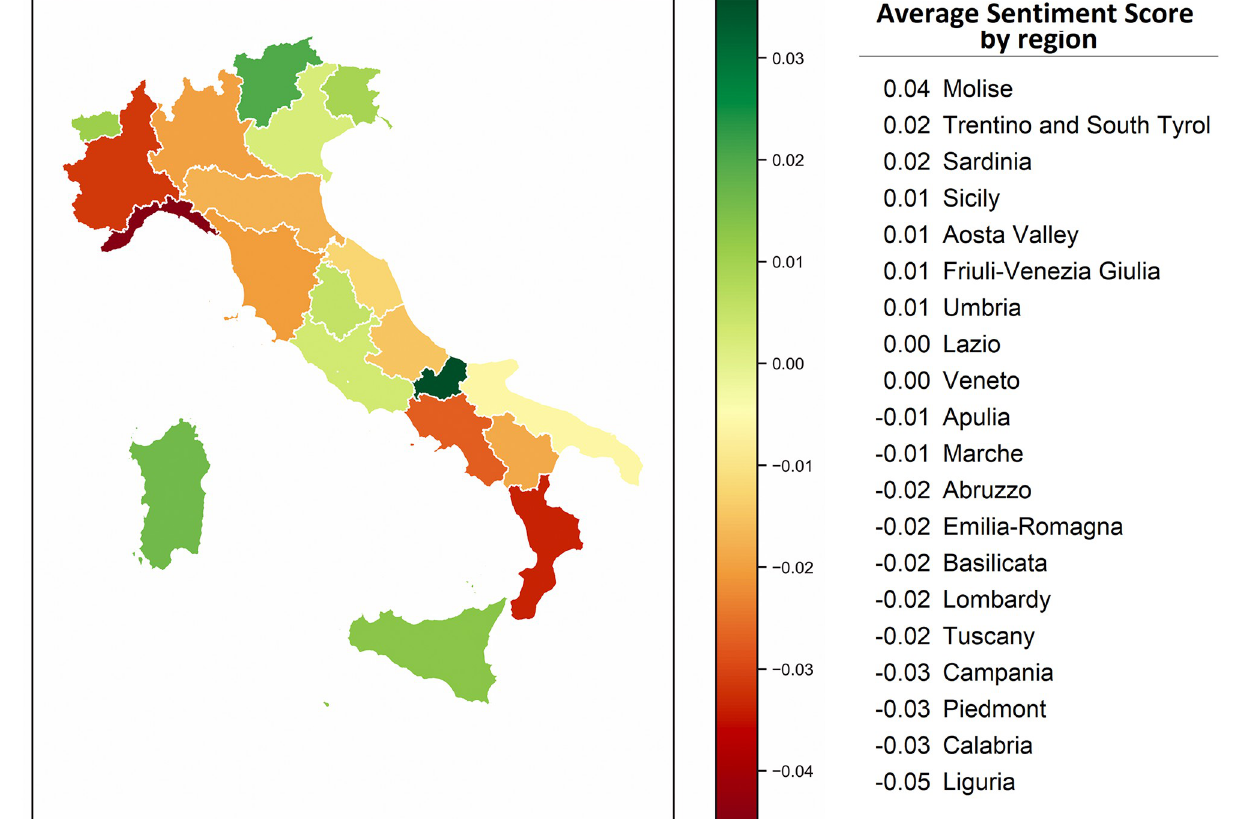
Fig 7. Average sentiment score in Italy by